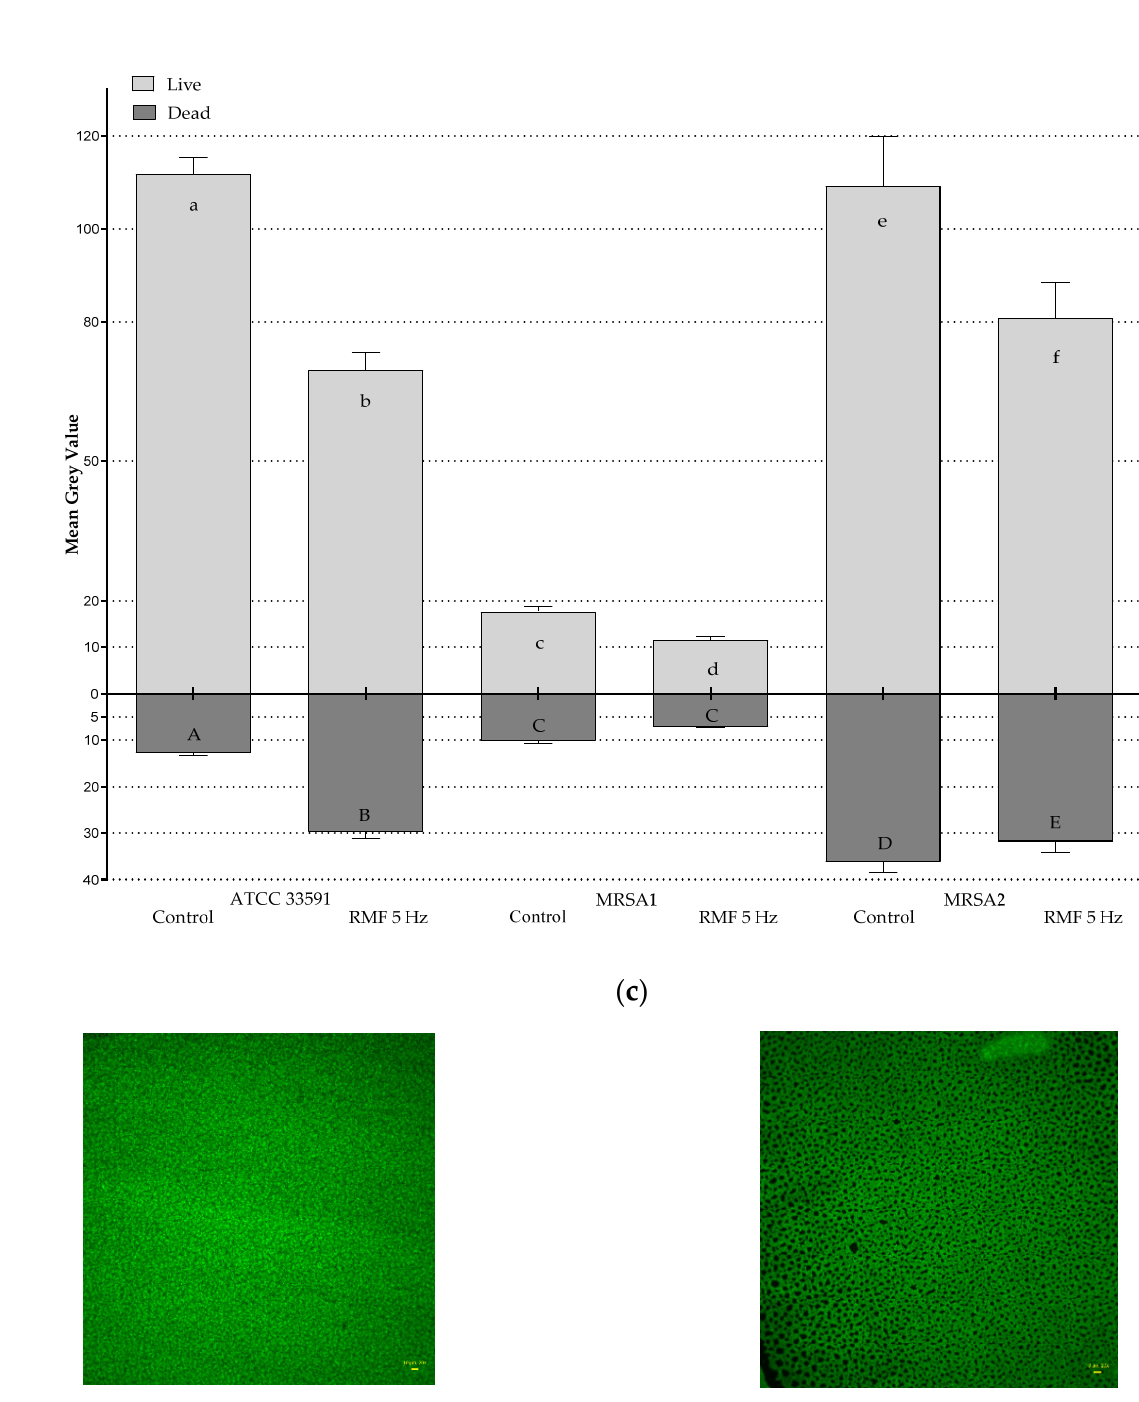
Figure 6. ( a ) The average intensity of fluorescence of dead and live MRSA cells after 12 h of RMF exposure (5 Hz) and in the control, unexposed setting, presented as differences in Mean Grey Value (MGV). ( b ) Picture of dyed with SYTO9 staphylococcal ATCC 33591 cells unexposed and ( c ) exposed to RMF (5 Hz). The results presented in ( a ) are shown as a mean MGV ± SEM calculated using 24 Regions of Interest (ROIs) obtained from four biological replicates. Different letters indicate statistical differences ( p < 0.05) between RMF-exposed and unexposed cultures of the same staphylococcal strain.